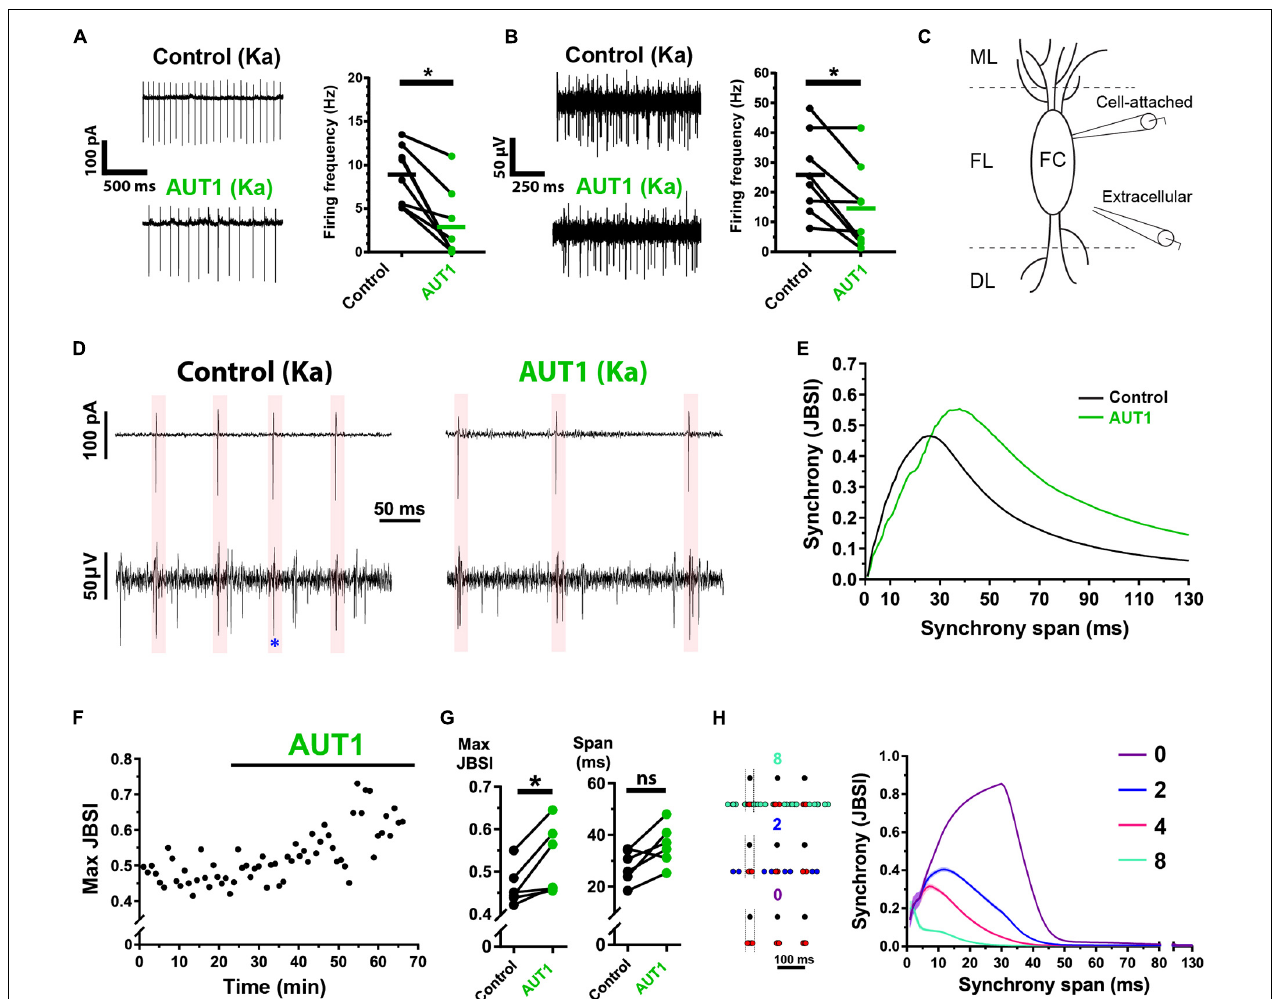
FIGURE 8 | Positive modulation of Kv3 K + currents increases local cross-unit synchrony of action potential firing in the fusiform layer of the dorsal cochlear nucleus. (A) Left: Example traces showing spontaneous action potential firing recorded from a fusiform cell using the cell-attached recording configuration, in the control (top) and AUT1 (bottom) conditions. Right: Perfusion of AUT1 decreased the firing frequency ( n = 8). (B) Left: Example traces showing spontaneous action potential firing recorded from the fusiform layer using the extracellular recording configuration, in the control (top) and AUT1 (bottom) conditions. Right: Perfusion of AUT1 decreased the firing frequency ( n = 8). (C) Schematic of the recording configuration allowing the measurement of cross-unit synchrony. ML, FL, and DL are the molecular, fusiform, and deep layer, respectively. FC = fusiform cell. (D) Simultaneous cell-attached recordings from a fusiform cell (top traces) and extracellular field potential recordings from the FL (bottom traces), in the control (left) and AUT1 (right) conditions. Shaded red areas allow visualizing cross-unit synchronous firing of action potentials. Blue asterisk in left (control) panel points to an action potential recorded in the cell-attached and extracellular recording configuration. (E) The jitter-based synchrony index (JBSI) is plotted as a function of synchrony span for an example brain slice recording in the control (black) and AUT1 (green) conditions. (F) The maximal peak of the JBSI curve is plotted as a function of experimental time for results depicted in panel (E) . (G) Perfusion of AUT1 increased the maximal JBSI (left, n = 6) but failed to affect the synchrony span at maximal JBSI (right, n = 6). (H) Left: Example portions of simulated cell-attached (reference, black dots, top rows) and extracellular (target, colored dots, bottom rows) spike times being either synchronous or asynchronous to each other. Numbers above the dots (0, 2, or 8) represent the number of asynchronous target spike times, represented as green and blue dots in the upper and middle rows, respectively. Target spike times occurring in phase with reference spike times are represented using red dots. Right: JBSI plotted as a function of synchrony span (ms) for simulated spike trains. Decreasing the number of asynchronous target spikes (number indicated in the inset) increases the maximal JBSI and shifts the JBSI versus synchrony span curve to the right. The time window in which synchronous target spike times occur with respect to a reference spike time is ± 10 ms (illustrated by the vertical dashed lines surrounding the first reference spike times). Shaded error bars = SD. * p <